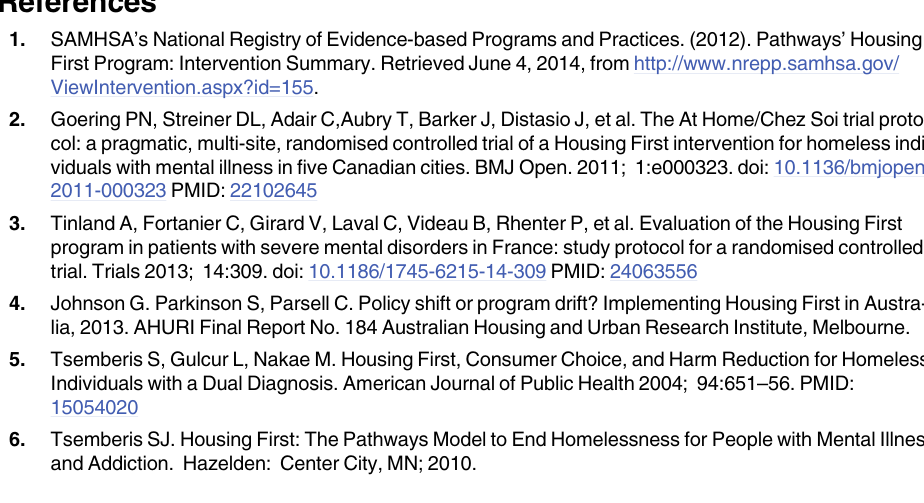
S2 Table. Mortality among ‘Vancouver At Home’ Participants (n = 297) by Study Arms S3 Table. Sensitivity analysis (non-missing cases) for effect of Housing First Intervention on Secondary Outcomes among VAH